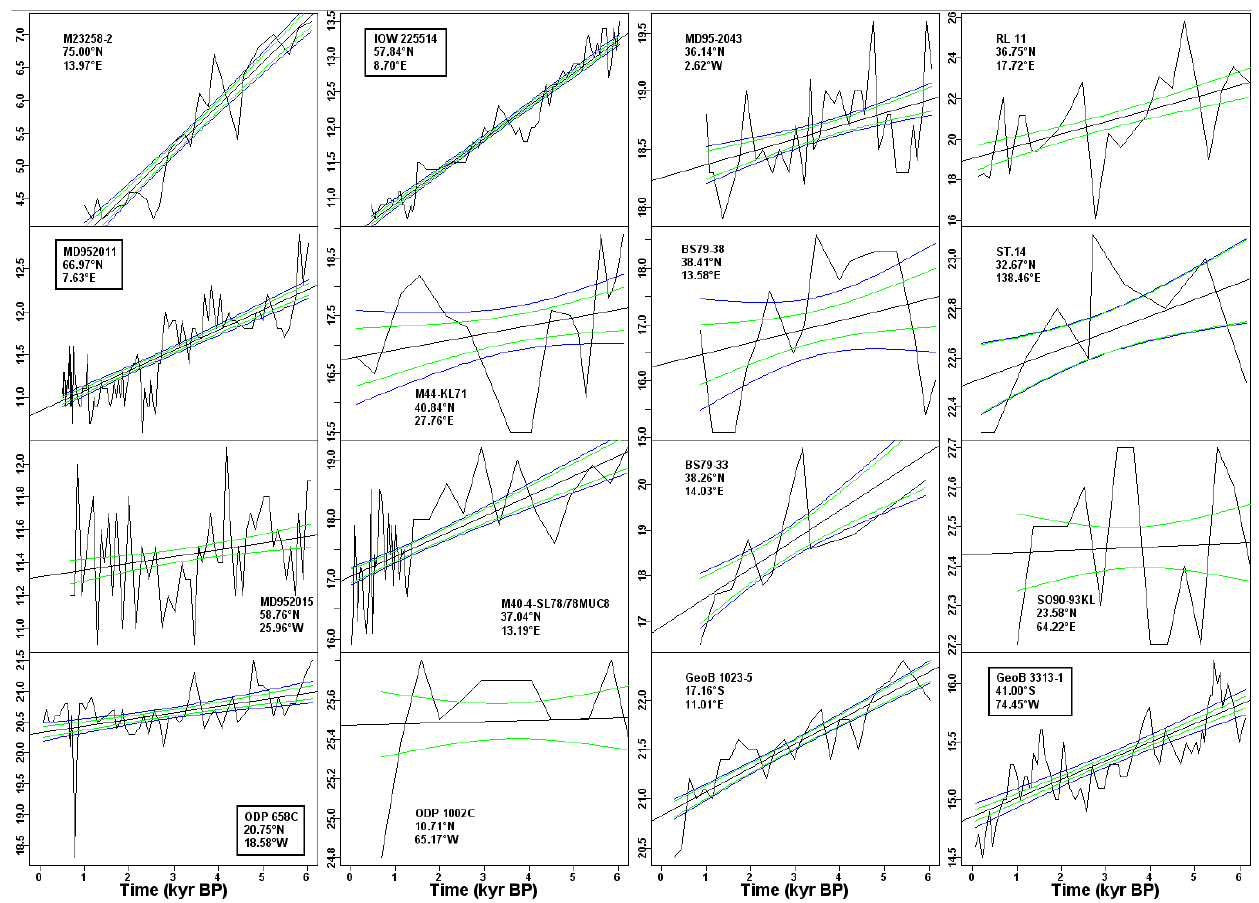
Figure 2 Fig. 2. As Fig. 1, but for cores with negative linear trends over the Holocene.